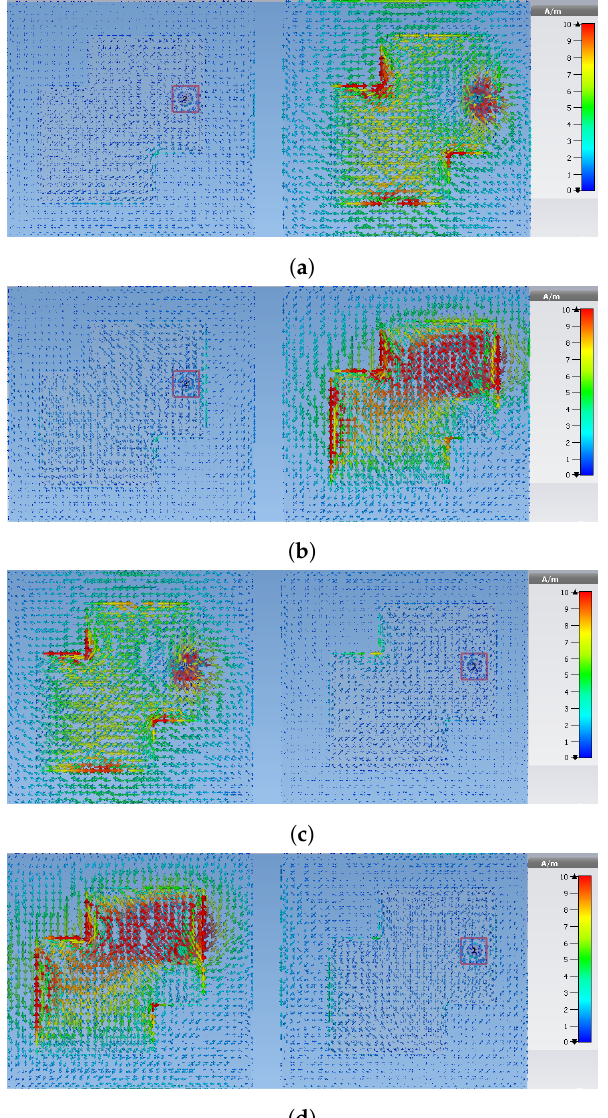
Figure 6. Simulated surface current distribution to demonstrate the generation of CP currents. ( a ) 0 ◦ due to port1; ( b ) 90 ◦ due to port-1; ( c ) 0 ◦ due to port-2; ( d ) 90 ◦ due to